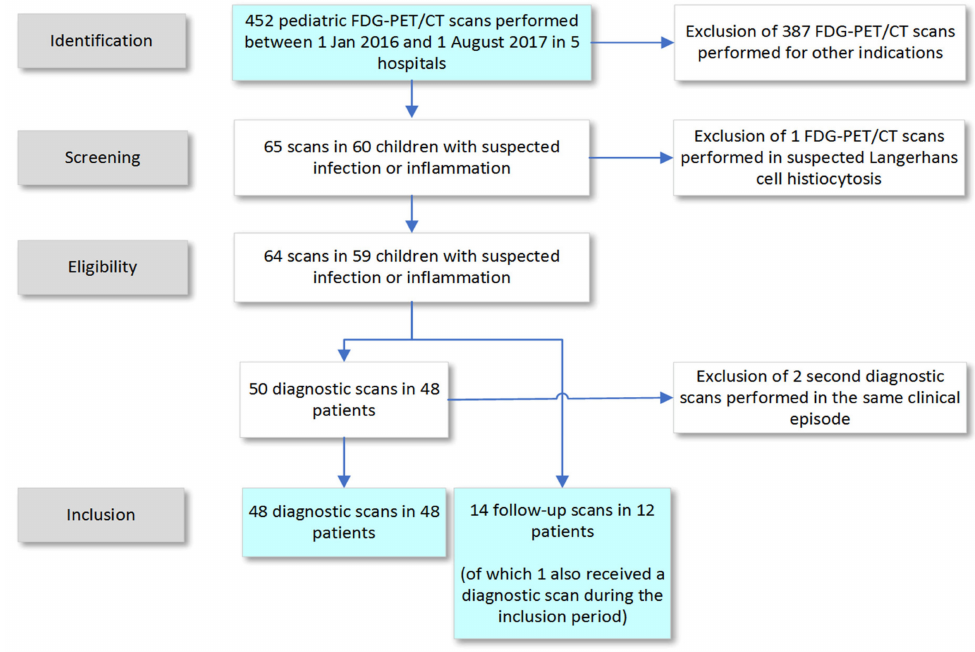
Figure 1. Selection of FDG PET / CT scans performed in five